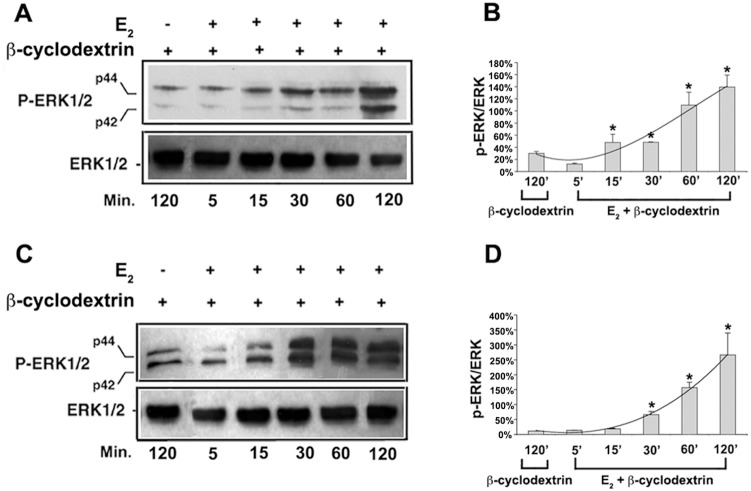
In A1 cells the different kinetics of p-ERK1/2 activation are abolished by β-cyclodextrin administration.Western blot detection of p-ERK1/2 and ERK1/2 proteins in proliferating (A) and non-proliferating A1 cells (C) treated at indicated time with E2 and ß-cyclodextrin. Two specific bands were observed respectively at 44 and 42 kDa. Each blot is representative of three separate experiments. The diagrams show the relative quantization of p-ERK1/2 and ERK1/2 in proliferating (B) and non-proliferating (D) A1 cells. Data are expressed as ratios of p-ERK1-2/ERK1-2. The trend line shows the kinetic of p-ERK1/2 following E2 stimulation. Asterisks represent p<0.01 when compared to control cultures treated with vehicle (ANOVA, Scheffè F-test).